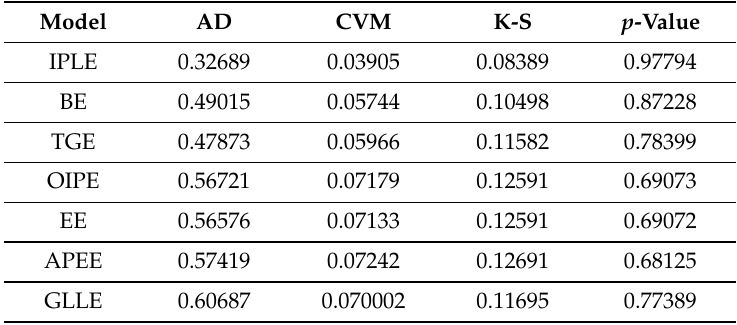
Table 7. The Anderson–Darling (AD), Cramér–von Mises (CVM), K-S, and p -value of the IPLE model and other fitted